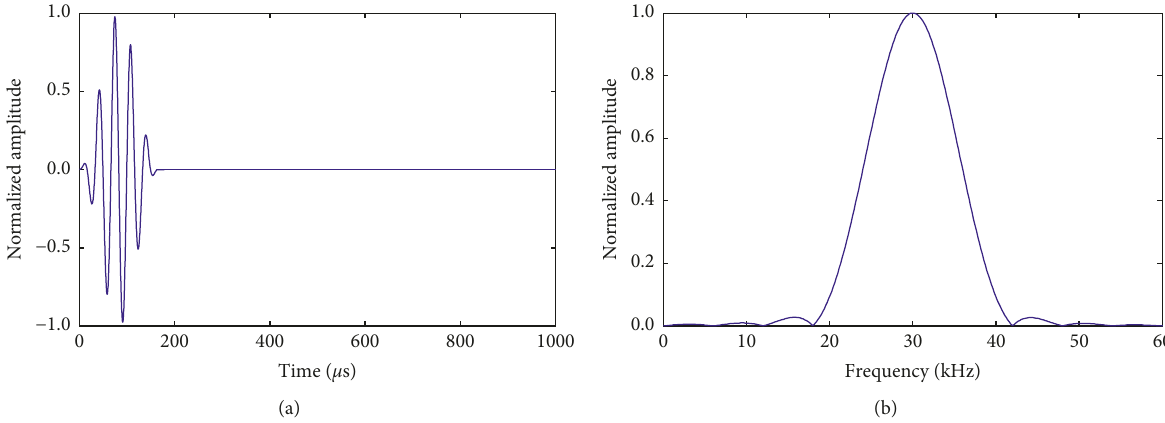
Figure 3: Excitation signal time-domain waveform (a) and spectrum (b).